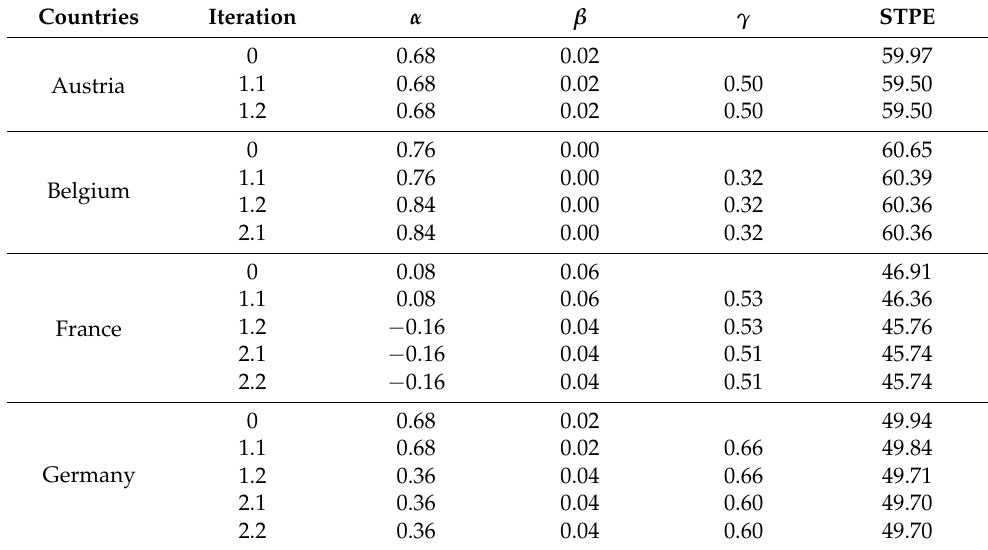
Table A1. Extended 2D- LQ : parameter values in each iteration process. Technical coefficient matrix.